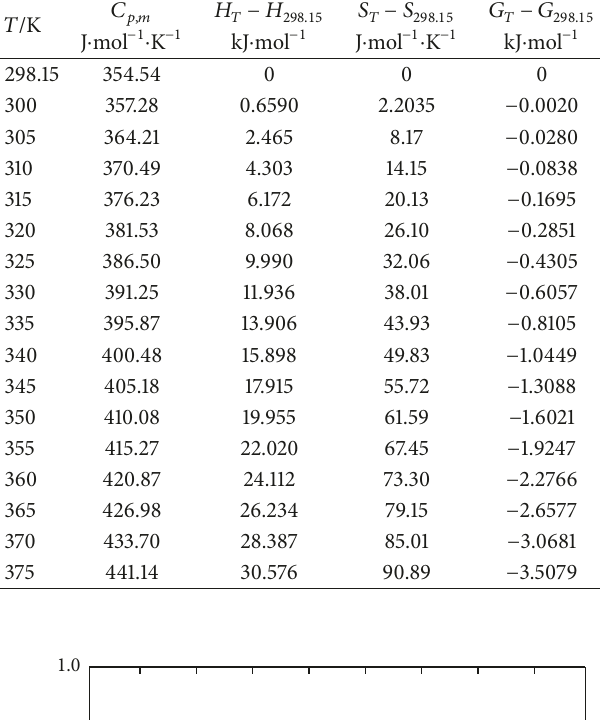
Table 2: Molar heat capacity of LiB 5 O 8 ⋅ 5H 2 O (molecular mass 𝑀 = 278.99 gmol −1 ).